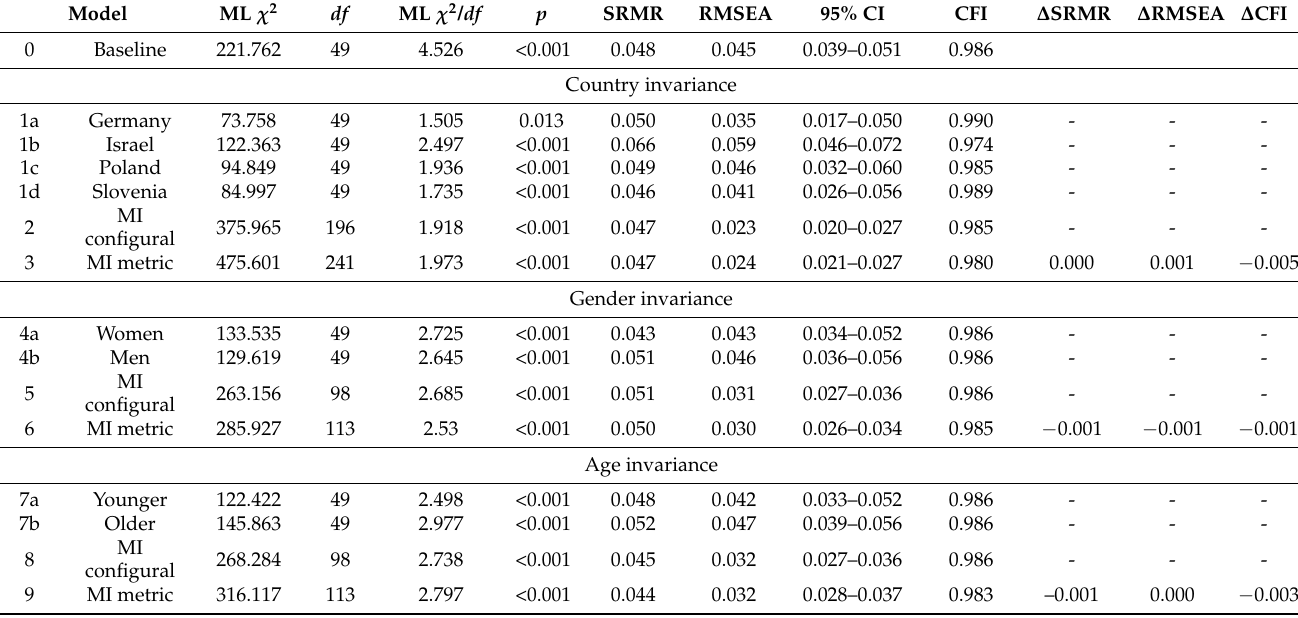
Table 3. Multigroup measurement invariance analysis for country, sex, age, and student